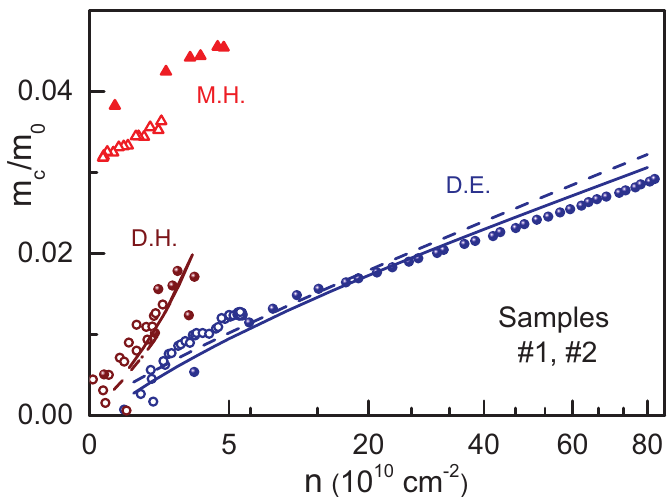
Figure 3. Cyclotron mass m c as a function of density n . Note the square root scale of the horizontal axis. The data from the gated sample #1 are shown by filled symbols, from the sample #2 without gate- by open symbols. Dirac electrons and holes are given by dark blue and brown circles, respectively. Massive holes are given by red triangles. The blue and brown lines are the predictions by the k · p model for Dirac electrons and holes, respectively. The difference between solid and dashed lines is due to splitting in the asymmetric potential and to the bulk inversion